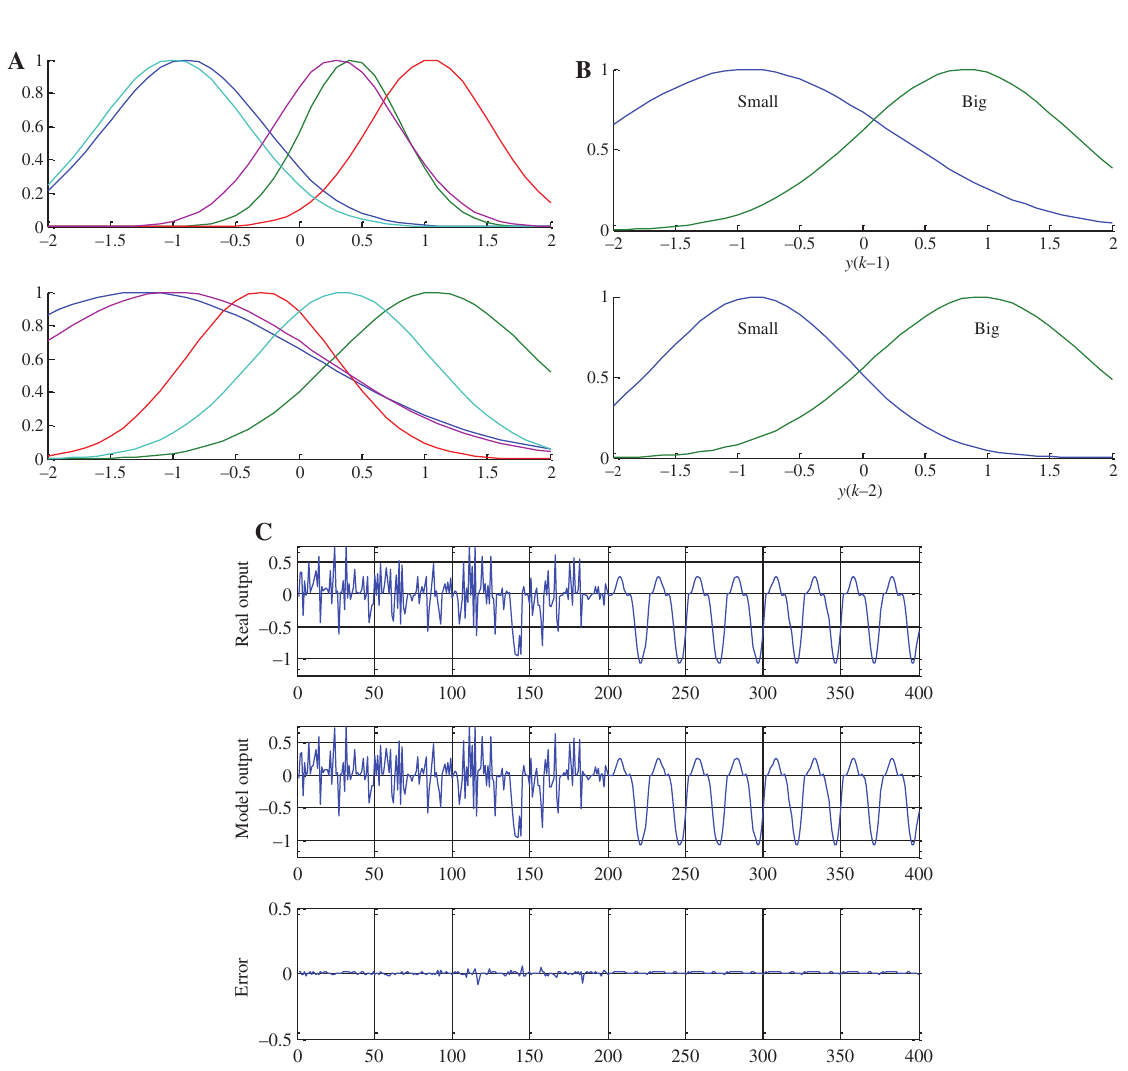
Figure 2: Fuzzy Sets Distribution and Simulation